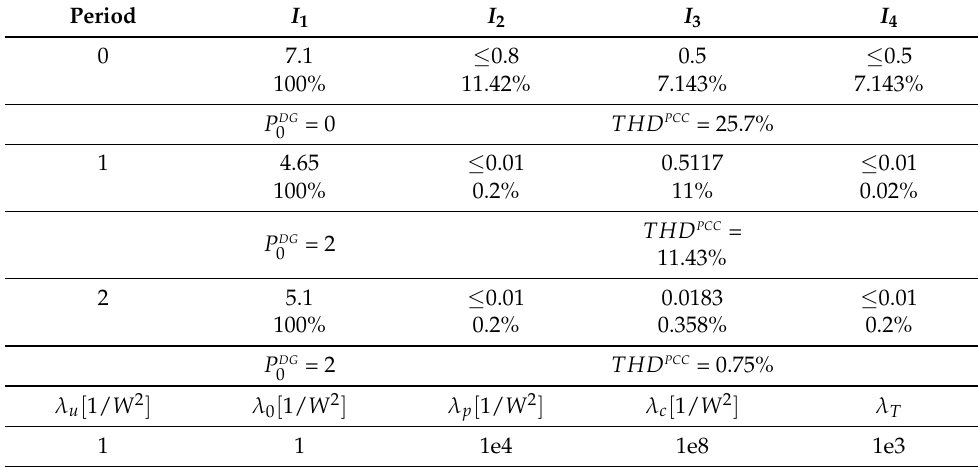
Table 3. Measured currents and weighting